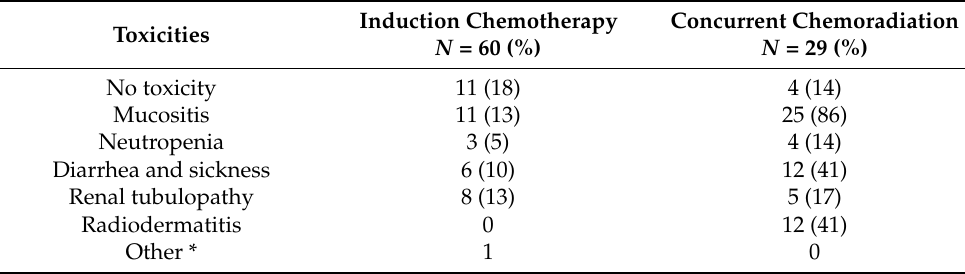
Table 2. Chemotherapy